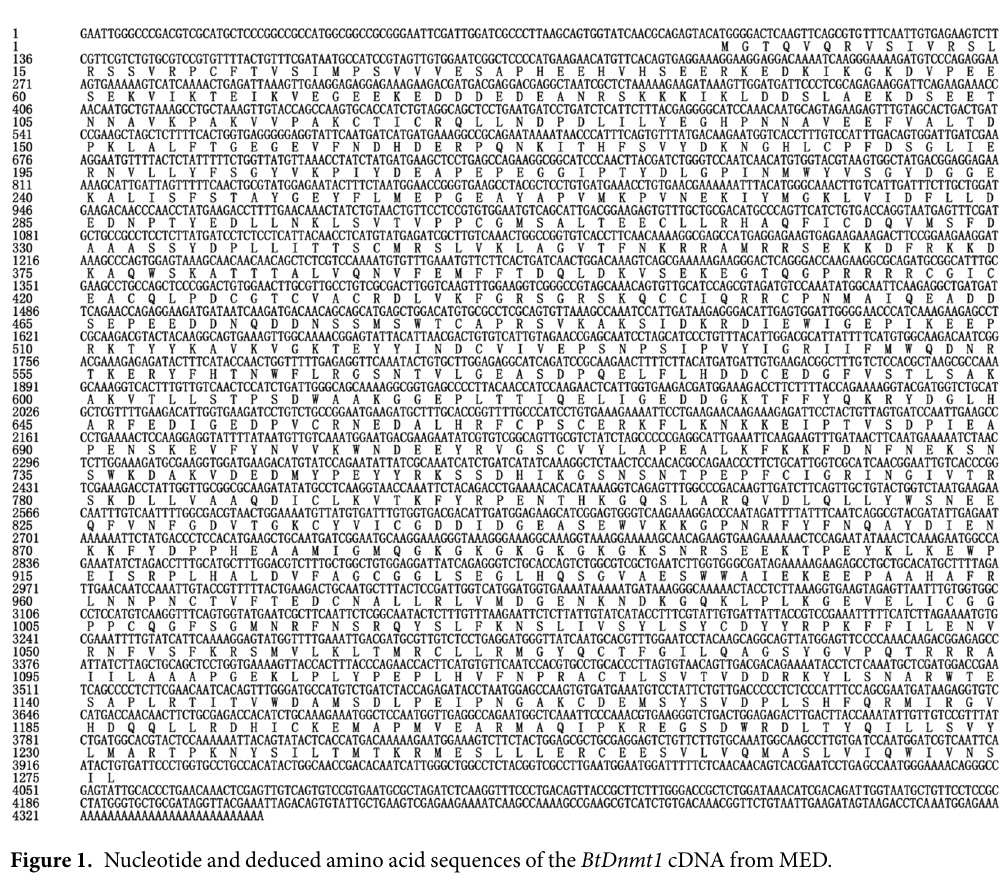
Figure 1. Nucleotide and deduced amino acid sequences of the BtDnmt1 cDNA from MED.